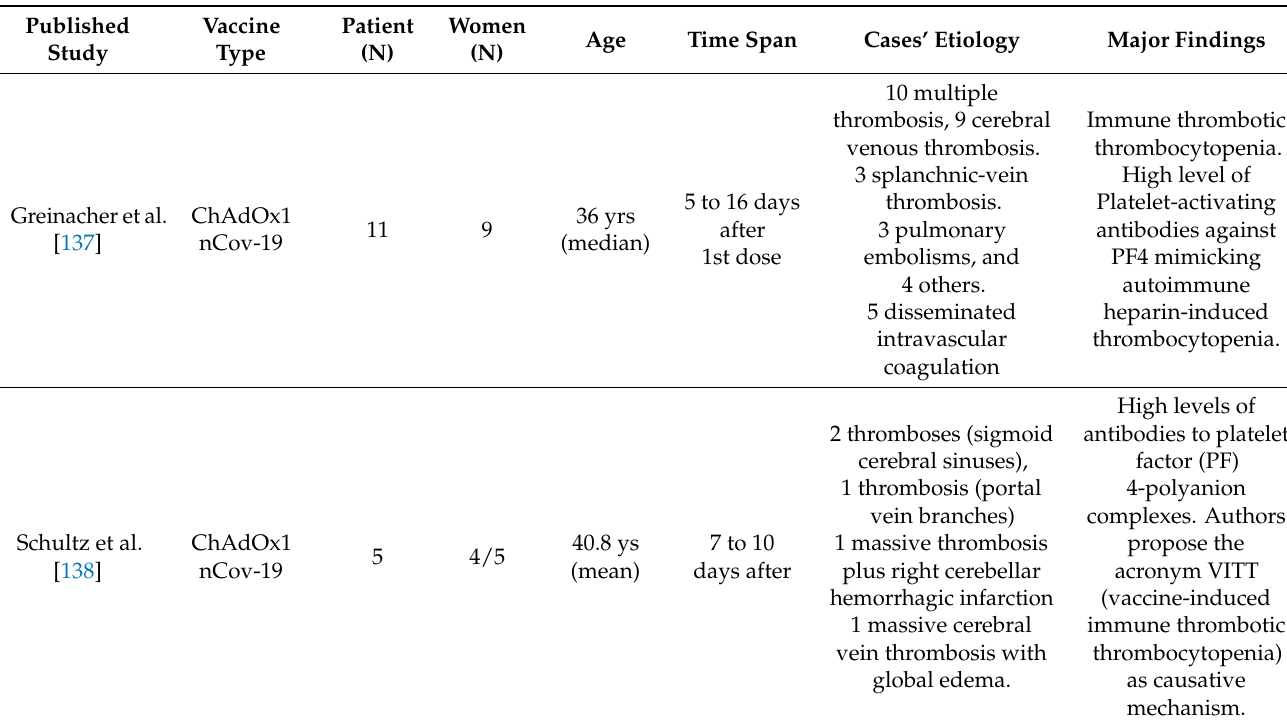
Table 2. Investigational studies related to ChAdOx1 nCov-19-associated thrombosis cases. We reported major findings, age (as median or mean) and female gender prevalence in number &/or percentage. PF: platelet